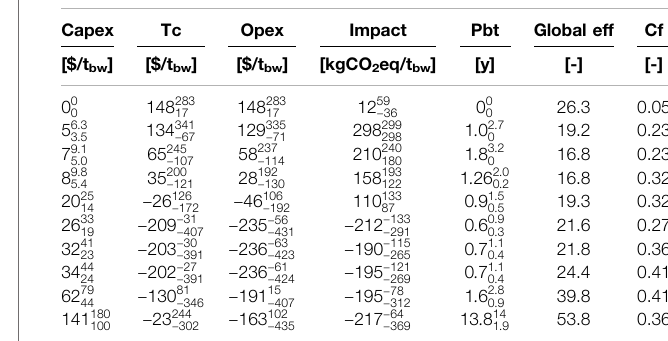
TABLE3| QuasiMonte-Carlosimulationresults(10,000)persolutionandperKPI. The central value represents the mean; sub- and superscript account for the upper and lower range of the 95%